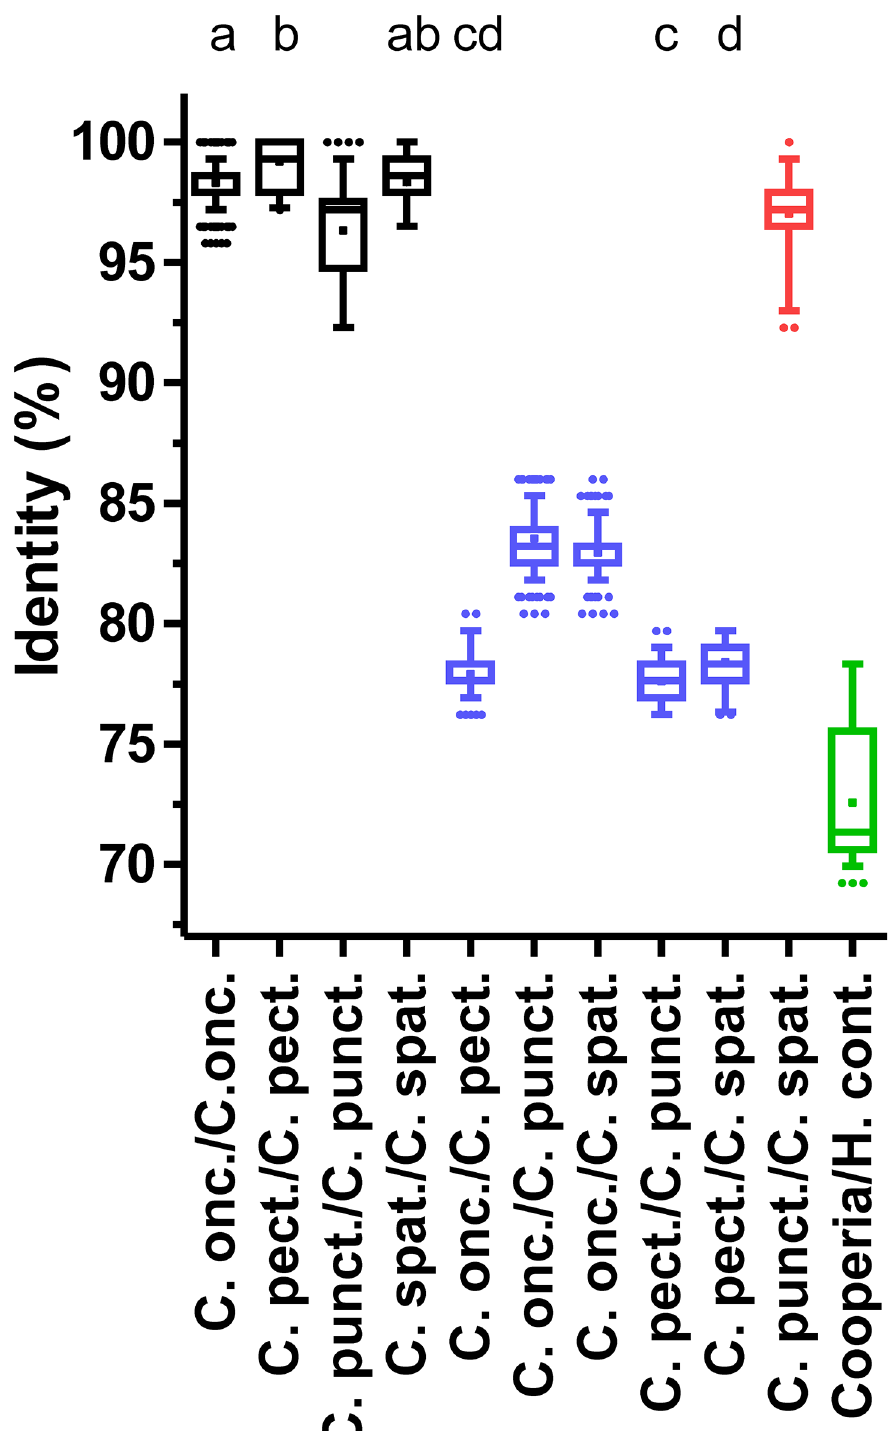
Fig 4. Pairwise sequence identities for intra- and inter-species comparisons at the 12S mitochondrial locus. Identities were calculated from a multiple sequence alignment of the partial mitochondrial 12S rRNA sequence. Identities are shown as box plots with whiskers representing 5–95% quantiles. Dots indicate outliers and the cross marks the means of the datasets. Intra-species comparisons are colored in black, inter-species comparisons within the genus Cooperia in blue and comparisons between C . punctata and C . spatulata in red. Comparisons between any